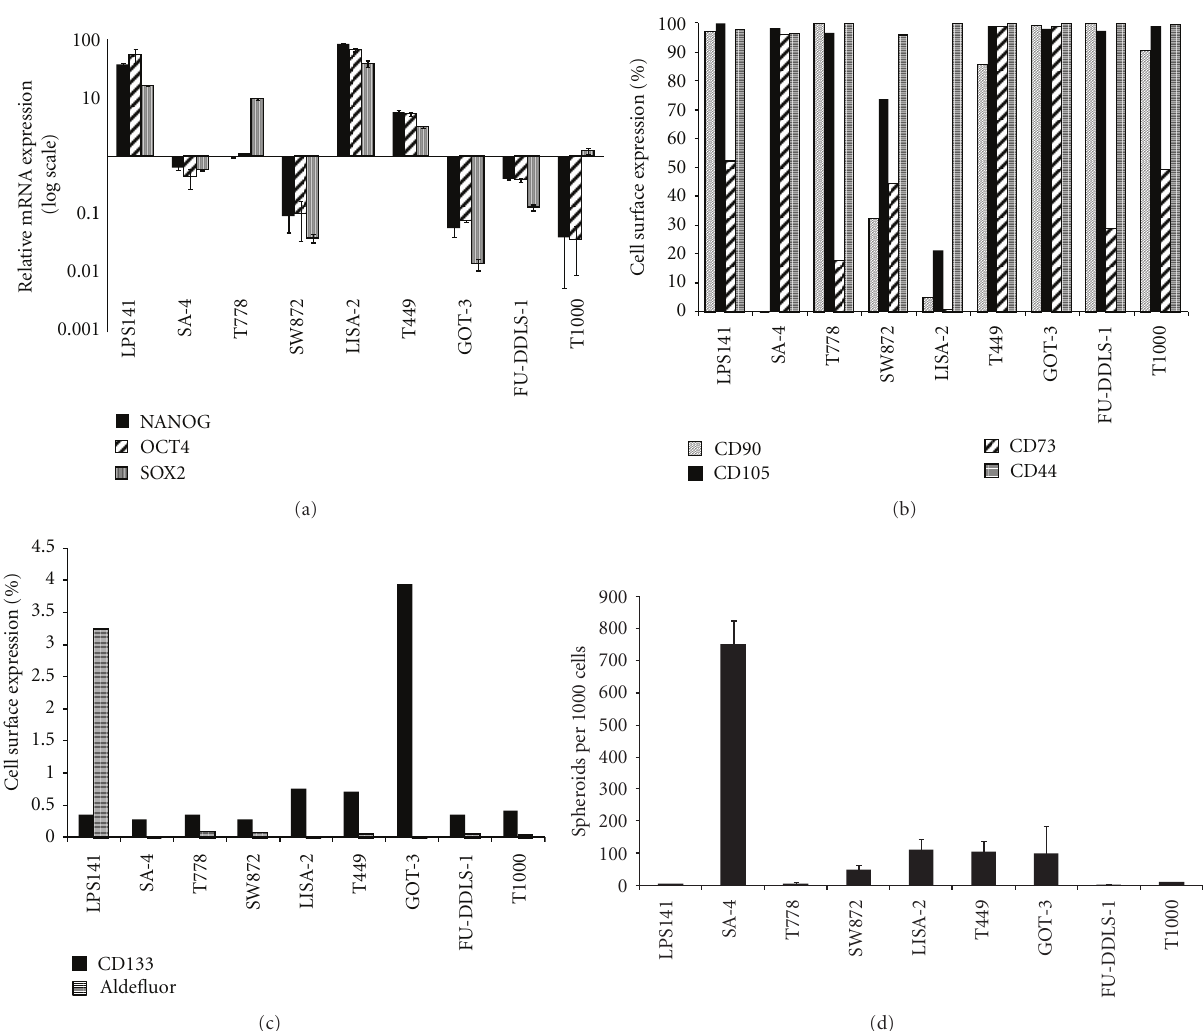
in vivo . Furthermore, the DDLPS-derived cell line,